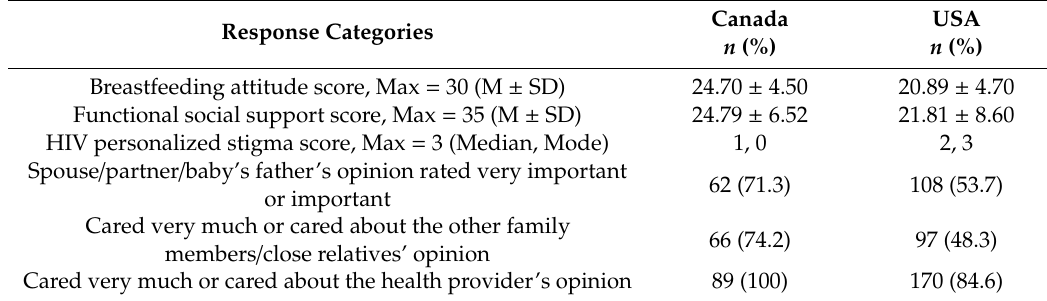
Table 2. Descriptive statistics of the outcome (breastfeeding attitudes) and other key predictor variables.